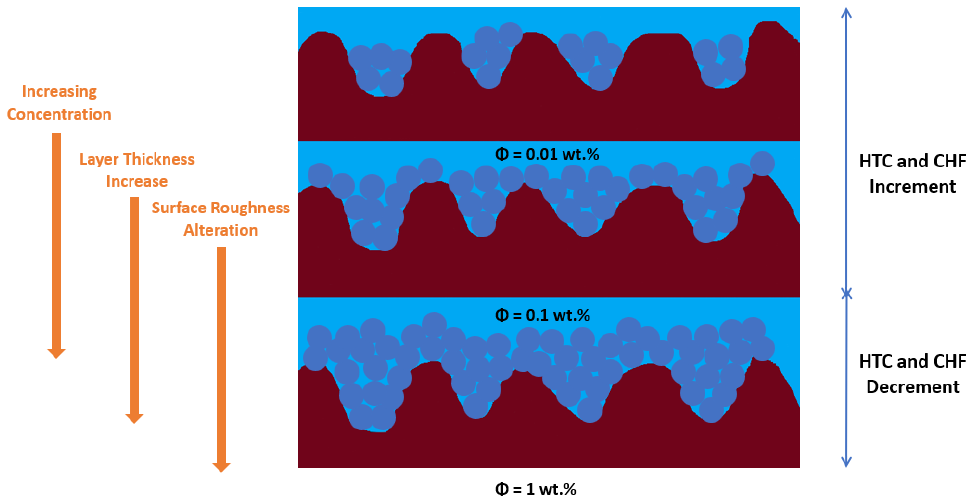
Figure 9. Schematic representation of the pool-boiling-induced nanoparticle deposition for different concentrations and effects on the heat transfer parameters.